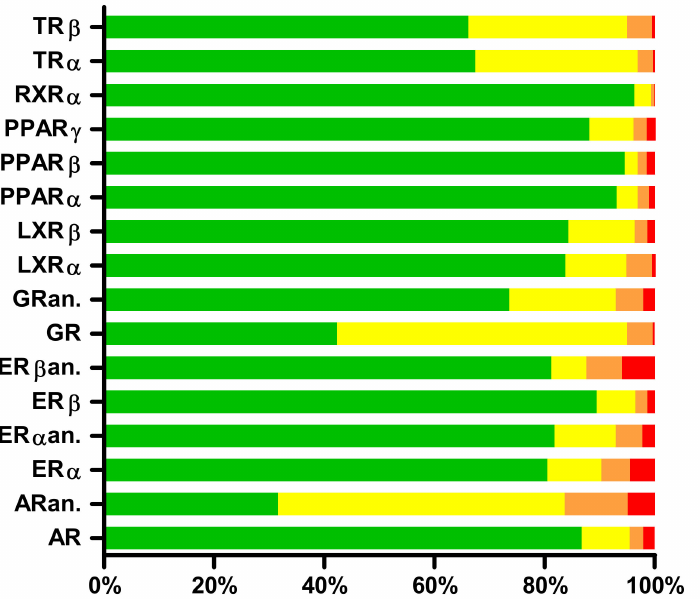
Figure 1. Binding a ffi nity distribution of 1046 tested drugs for 12 nuclear receptors as assayed with Endocrine Disruptome. Green corresponds to a low probability of binding, yellow and orange correspond to a medium probability of binding, and red corresponds to a high probability of binding